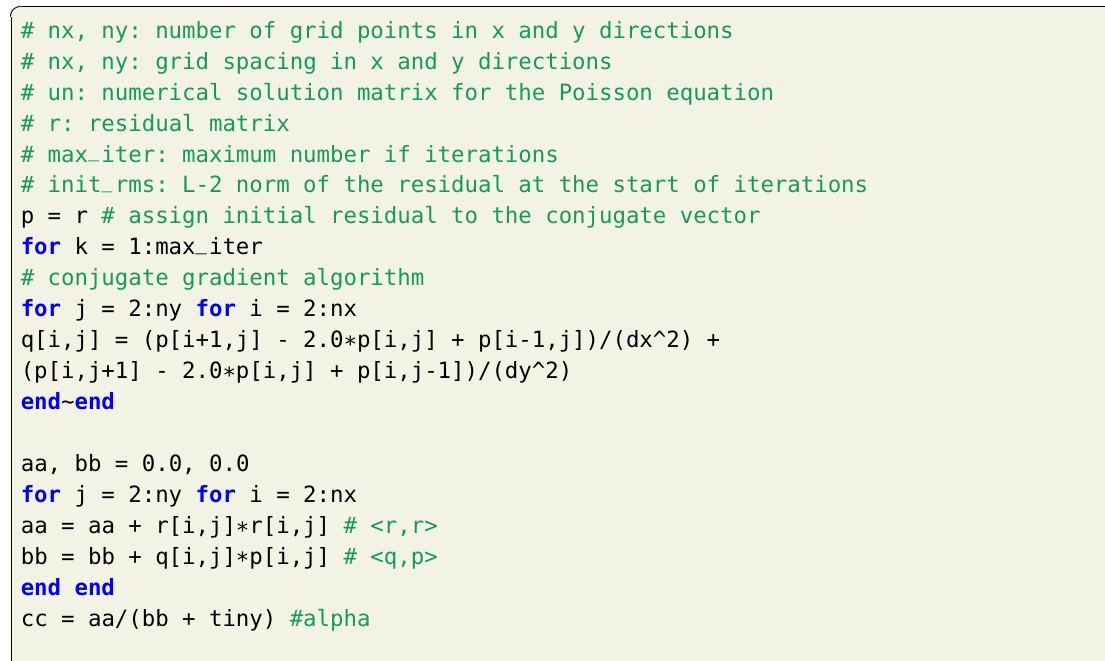
Listing 22. Implementation of conjugate gradient method for Poisson equation in Julia.